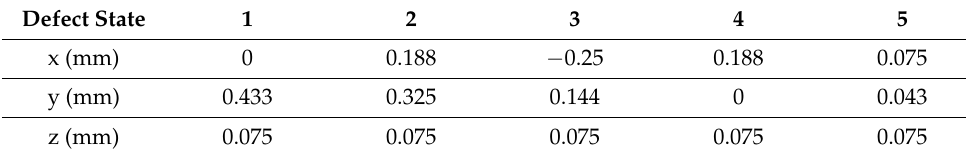
Table 2. The centroid coordinates of each defect state